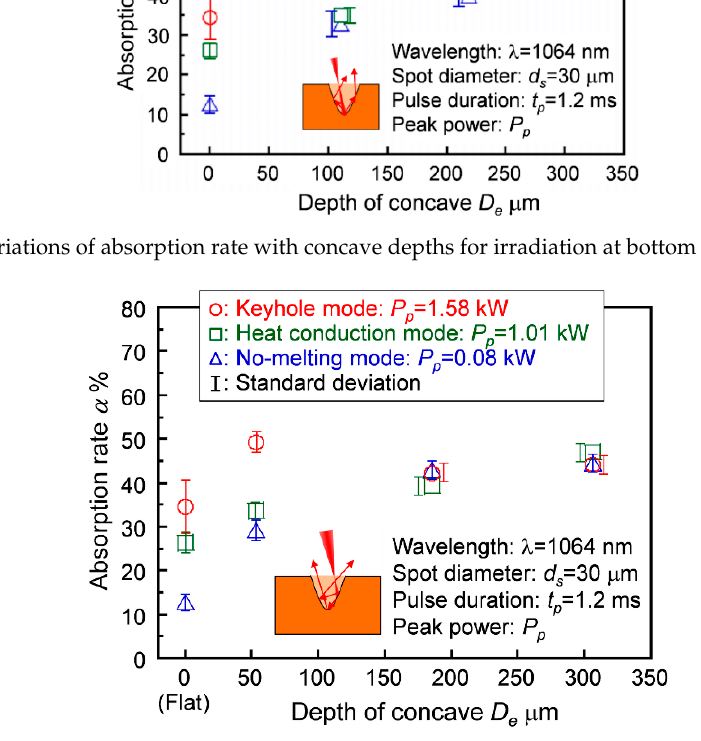
Figure 6. Variations of absorption rate with concave depths for irradiation on concave walls.